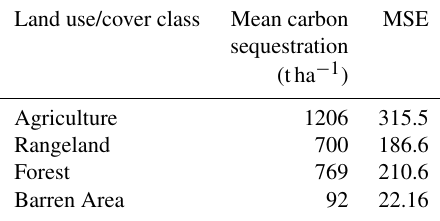
Table 8. Total carbon sequestration per land use/cover